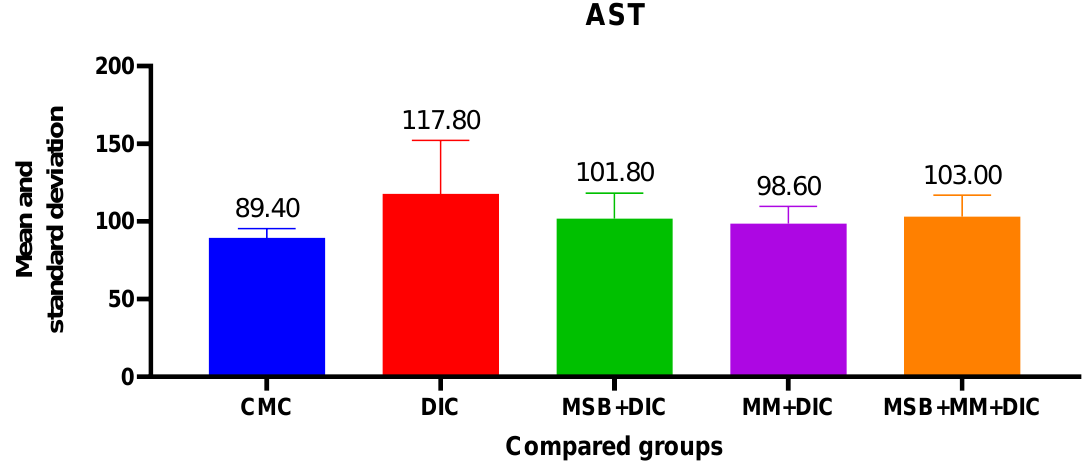
Figure 6. Mean value and standard deviation of AST between analyzed groups. Group I-CMC, negative control group; group II-DIC, disease control group; group III-MSB+DIC, group receiving MegaSporeBiotic; group IV-MM+DIC, group receiving MegaMucosa; group V-MM+MSB+DIC, group receiving MegaSporeBiotic and MegaMucosa.